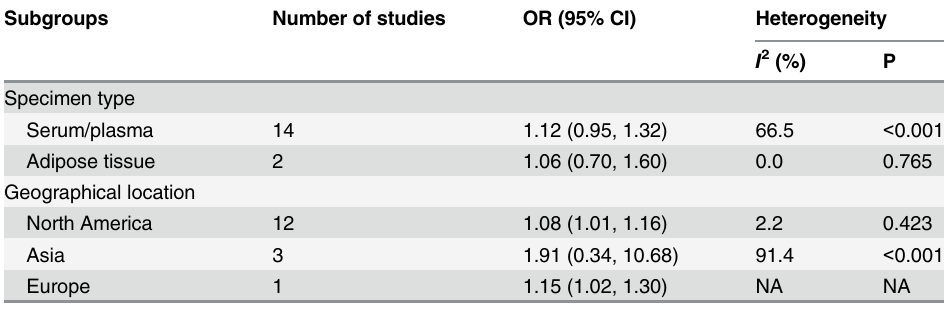
Table 3. Subgroup analyses for retrospective studies of total